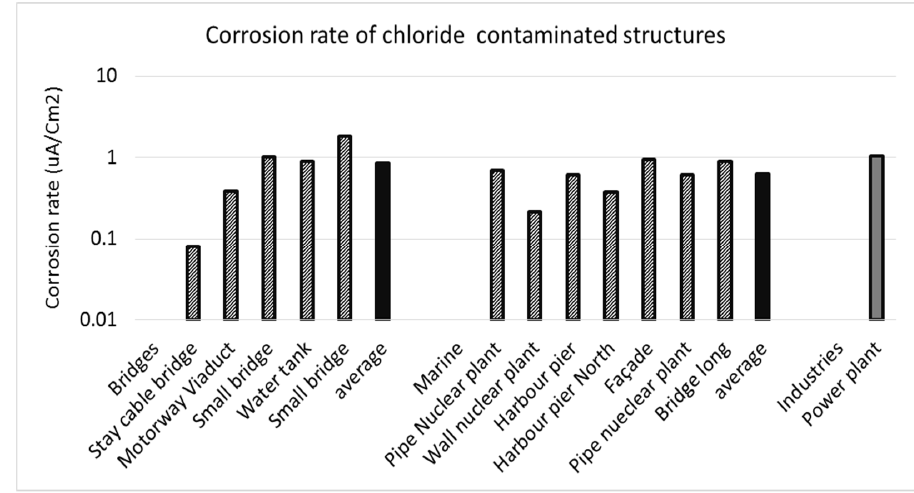
Figure 3. Average values of corrosion rate in different structures contaminated by chlorides.